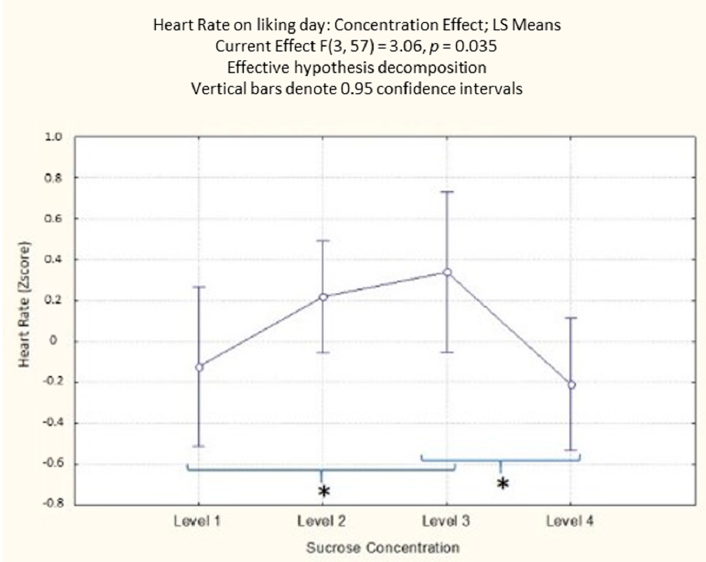
Figure 6. Concentration effect on HR with different sucrose concentration levels in the liking evaluation day. The order of the levels corresponds with the different sucrose amounts (38; 83; 119; 233 g/kg). * Denotes a significance level < 0.05.